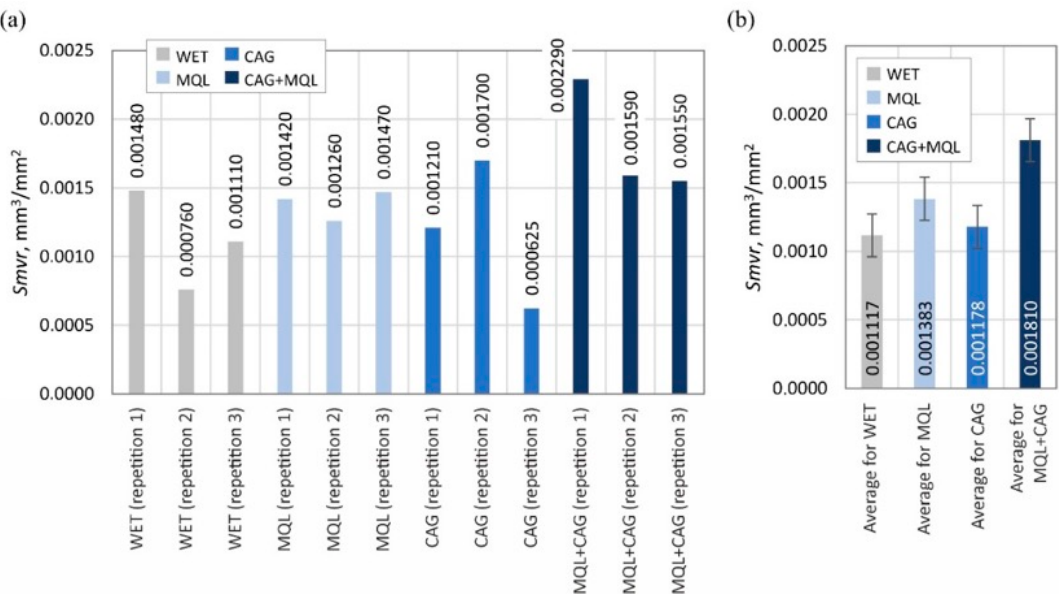
Figure 9. Chart of changes in the mean void volume ratio Smvr : ( a ) results for the twelve blades selected for the surface texture measurements; ( b ) mean values of the parameters divided by cooling and lubrication methods of the grinding zone used during the shaping of the blades (error bars